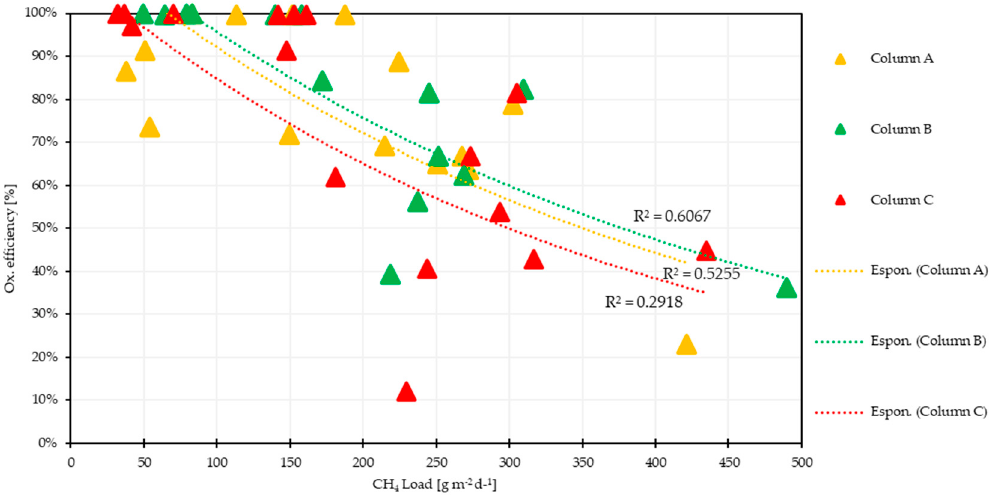
Figure 4. Relationship between methane load and oxidation efficiency for different filter media moisture content.